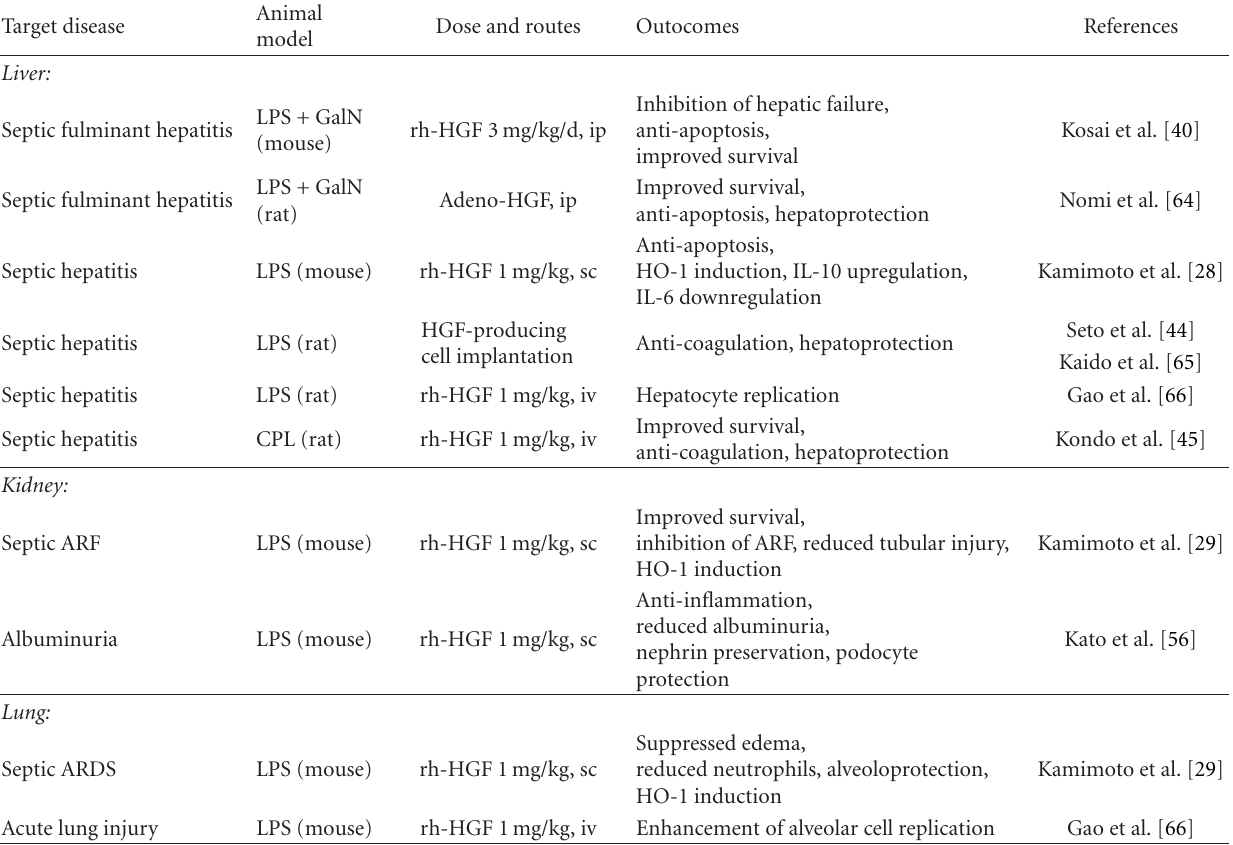
Table 3: Landmark studies to demonstrate the therapeutic e ff ect of HGF on sepsis-related MOF in animal models. Target